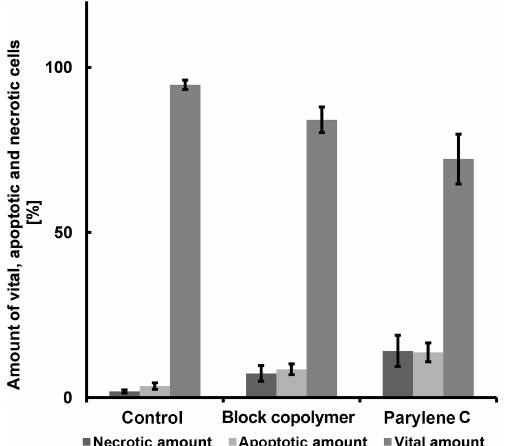
Figure 9. Vital, apoptotic and necrotic amount of cells after PI staining detected by means of the FACScan ( n =